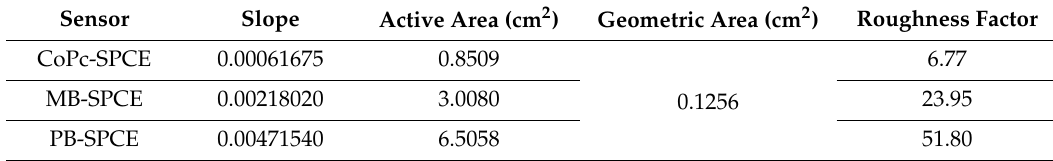
Table 1. The active surface areas and the roughness factors of the modified